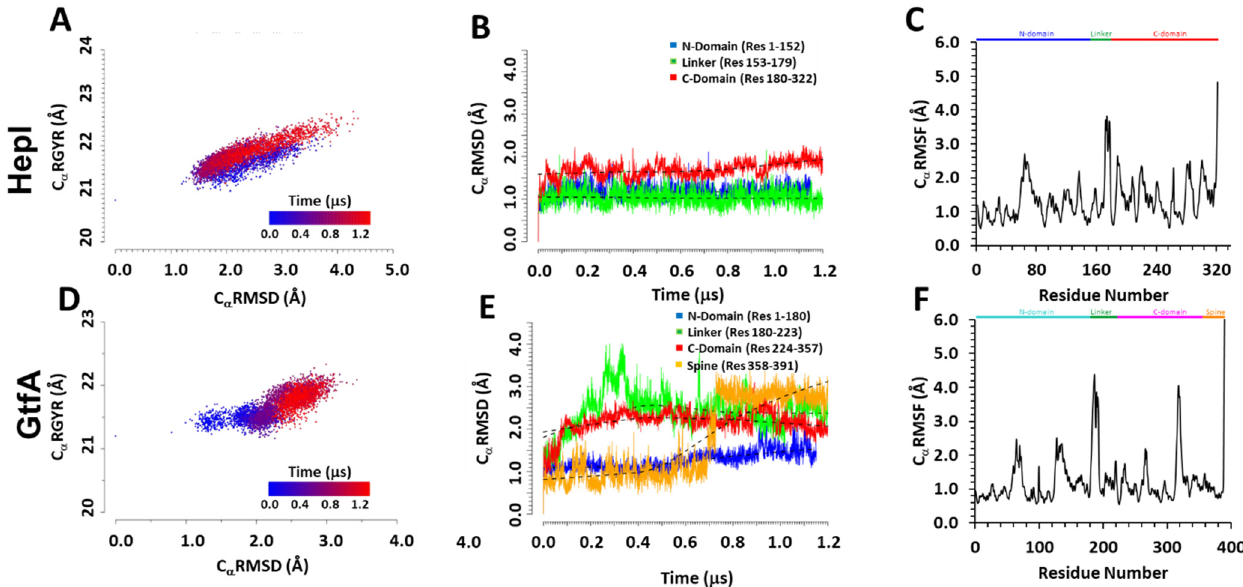
Figure 2. Computed radius of gyration (C α RMSD), root-mean-square deviation (C α RMSD), and root-mean-square fluctuation (C α RMSF) of alpha-carbon atoms in HepI ( A – C ) and GtfA ( D – F ). ( A , D ) The correlation between C α RGYR and C α RMSD, highlighting the change in conformation population over the course of MD simulation from that determined at 0.0 (blue) to 1.2 µs (red); ( B , E ) the variations of C α RMSD divided into different glycosyltransferase domains over the course of the entire simulation. Black dotted curves represent lowess curves for each domain. ( C , F ) The C α RMSF plot with secondary structures, α -helix and β -sheet regions, highlighted in blue and yellow, respectively.